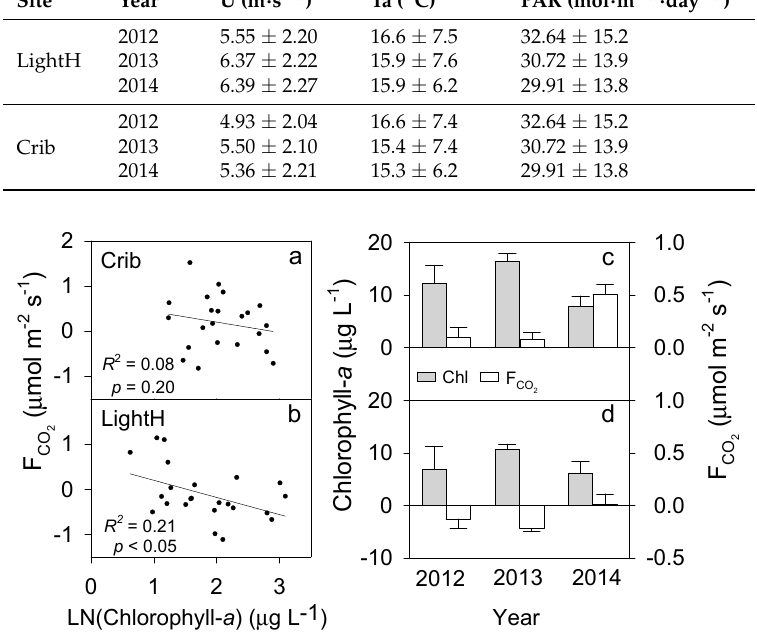
Table 1. The mean values ( ± standard deviation) of wind speed (U), air temperature (Ta), and photosynthetically active radiation (PAR) April–November at the LightH and Crib sites. PAR values used in this study were cross-validated between the two sites; thus, the same values are reported.